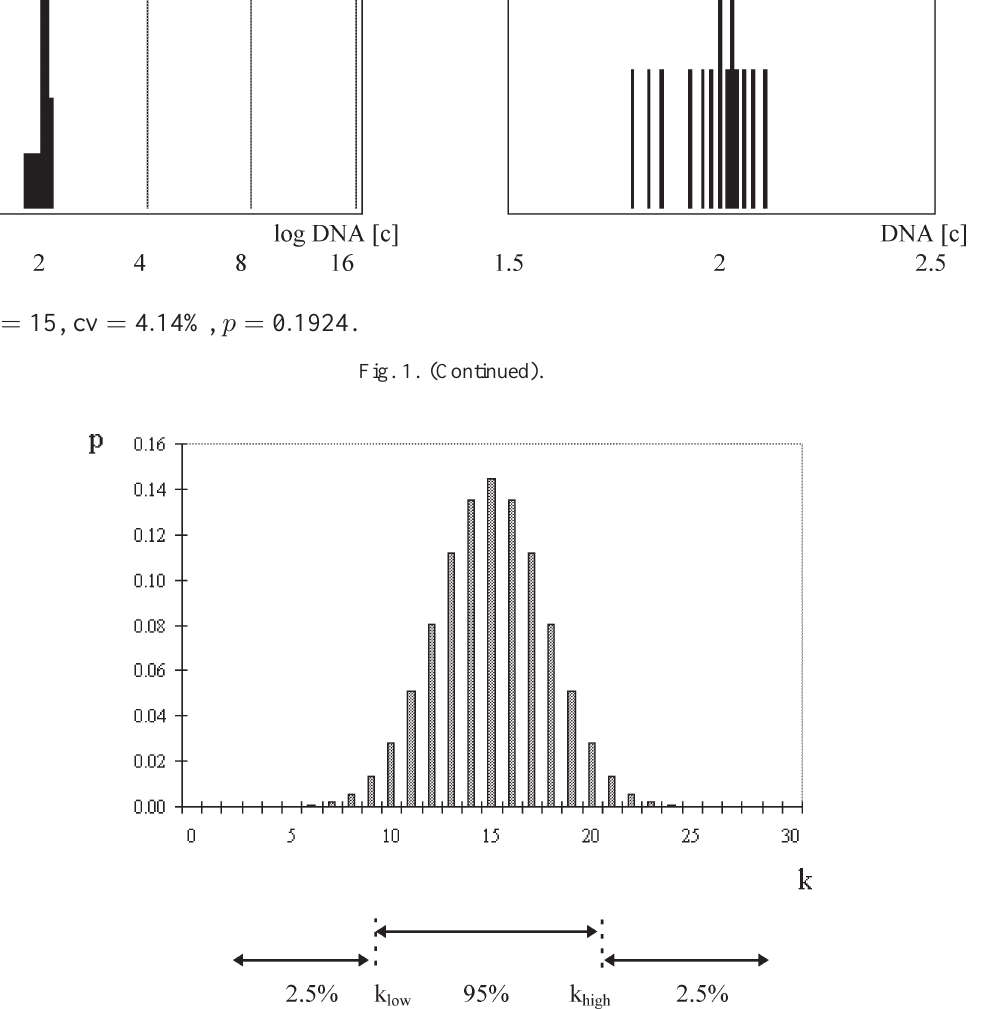
Fig. 2. Binomial distribution for n = 30 and p = 0 . 5. In this distribution 95% of all values k are between k low = 9 (with p low = 0 . 025) and k high = 21 (with p high = 0 .